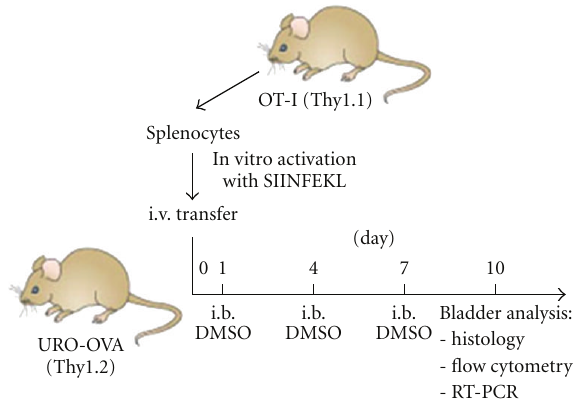
Figure 1: Cystitis induction and intravesical DMSO treatment schedule in URO-OVA mice. URO-OVA mice (Thy1.2) were transferred i.v. with in vitro preactivated OT-I splenocytes (Thy1.1) for cystitis induction at day 0, treated intravesically (i.b.) with 50% DMSO at days 1, 4, and 7 and sacrificed for analysis at day